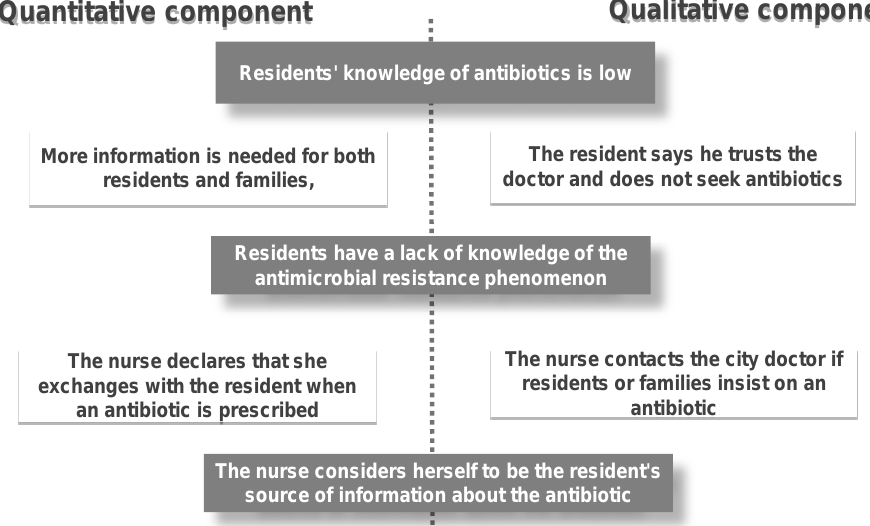
Figure 2. Results from both methods of analysis. Grey: Convergences. White: Findings of a single method.